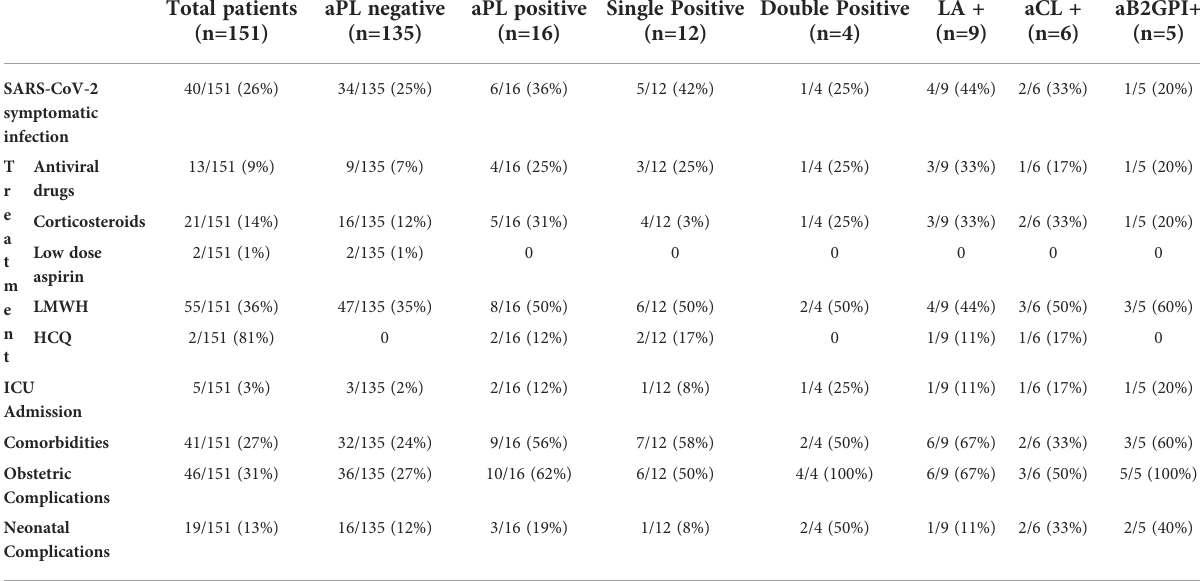
TABLE 1 Characteristics of 151 patients with SARS-CoV-2 divided upon the positivity for antiphospholipid antibodies (aPL). Total patients